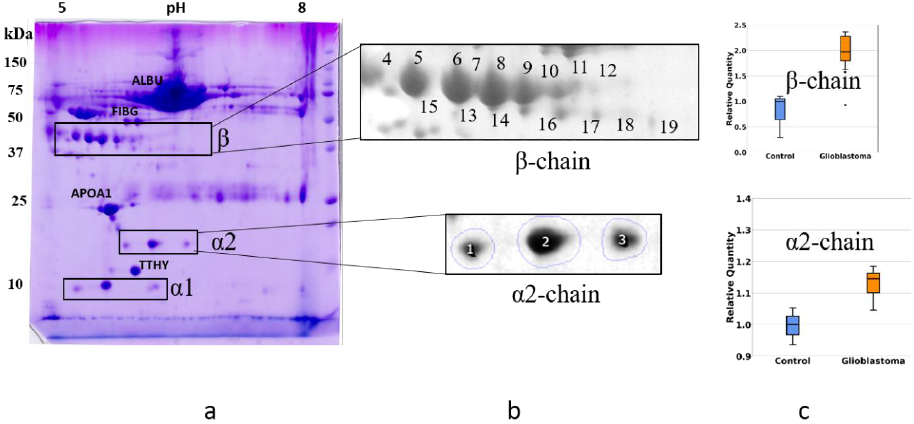
Figure 3. The comparative 2DE analysis of the abundance of Hp α 2- and β -chain proteoforms in plasma of control and GBM patients. A representative Coomassie-stained 2DE gel of plasma proteins (GBM) with identified positions of α - and β -chains ( a ). The enlarged areas with spots containing α 2- and β -chain proteoforms ( b ). MS data about proteins detected in different spots can be found in the Supplementary Materials Table. A comparative statistical analysis of sum spot intensities in control and GBM samples ( c ).